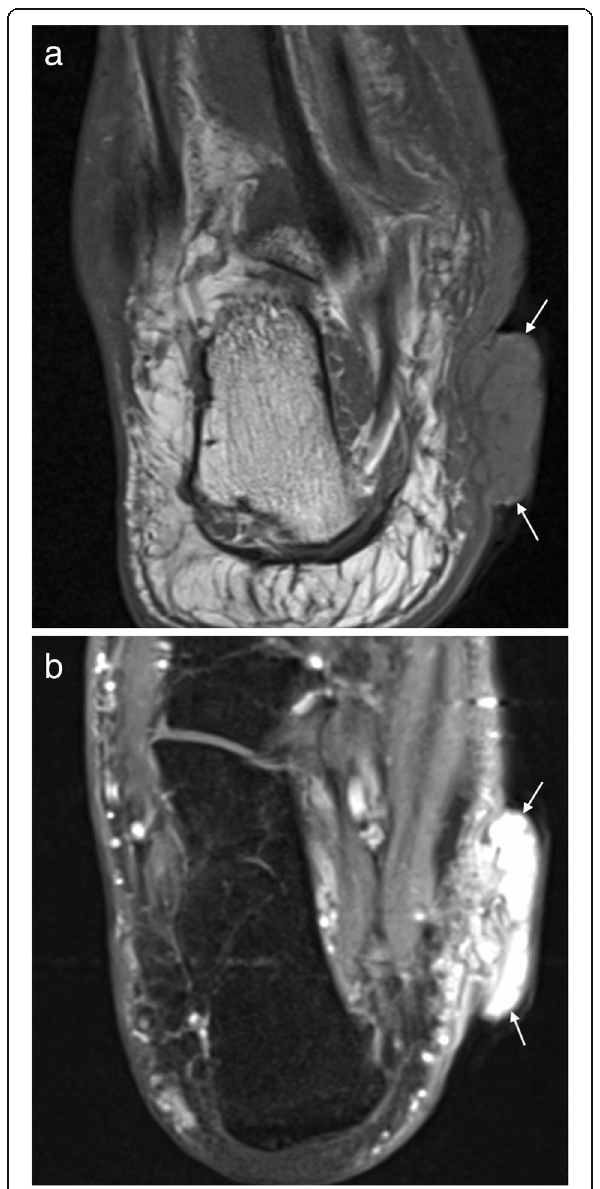
Fig. 13 Kaposi ’ s sarcoma. Coronal T1W ( a ) and post-contrast T1FS ( b ) images of the foot showing an exophytic lesion, low signal on T1W with avid enhancement and a nodular proliferation of the dermis